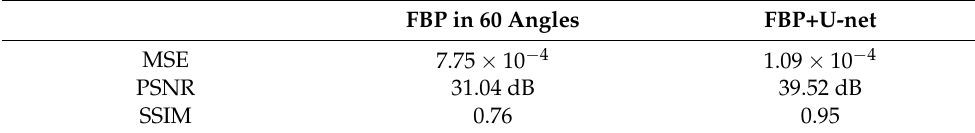
Table 5. Reconstruction metrics for industrial data.